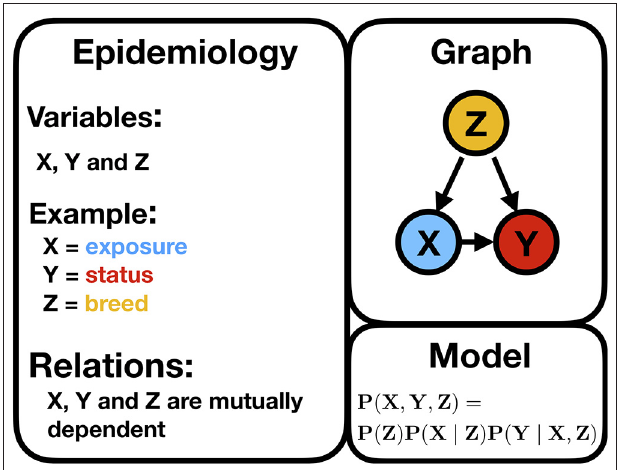
FIGURE 3 | Illustration of a typical confounding situation described in the text stating the biologically expected relationships, a DAG, and the corresponding statistical model encoding the joint probability